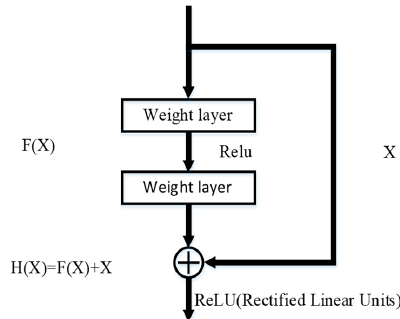
Figure 2. Residual learning module. Since direct mapping is difficult to learn, the basic mapping relationship from X to H(x) is no longer being learned, but the difference between the two is learned, which is the residual, and in order to calculate H(x), this residual is simply added to the